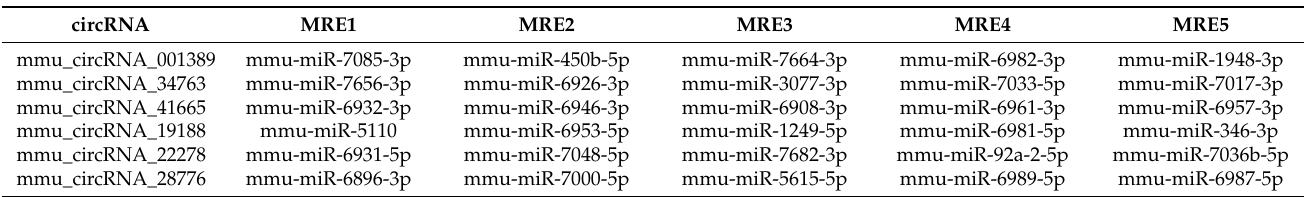
Table 3. miRNA binding sites of